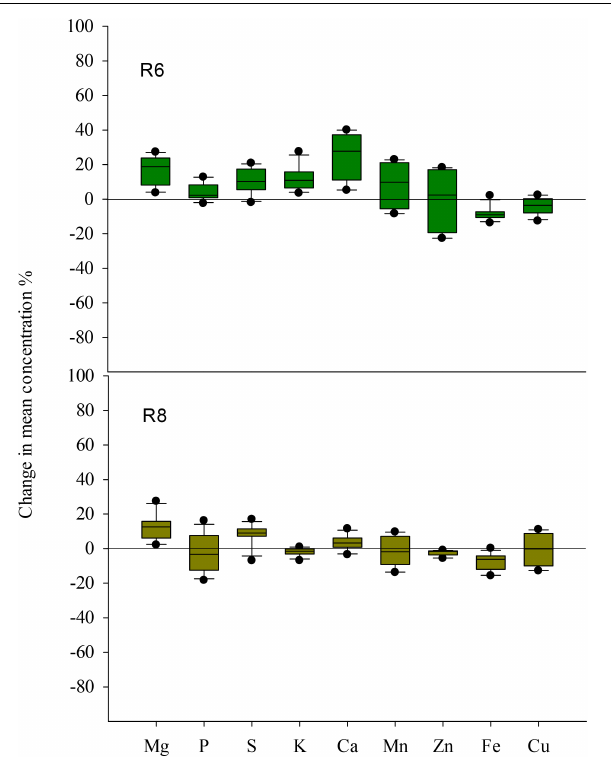
FIGURE 6 | Boxplot shows the mean response ratio of the grain chemical element concentrations of four soybean cultivars under elevated CO 2 at the fresh edible (R6) and mature stages